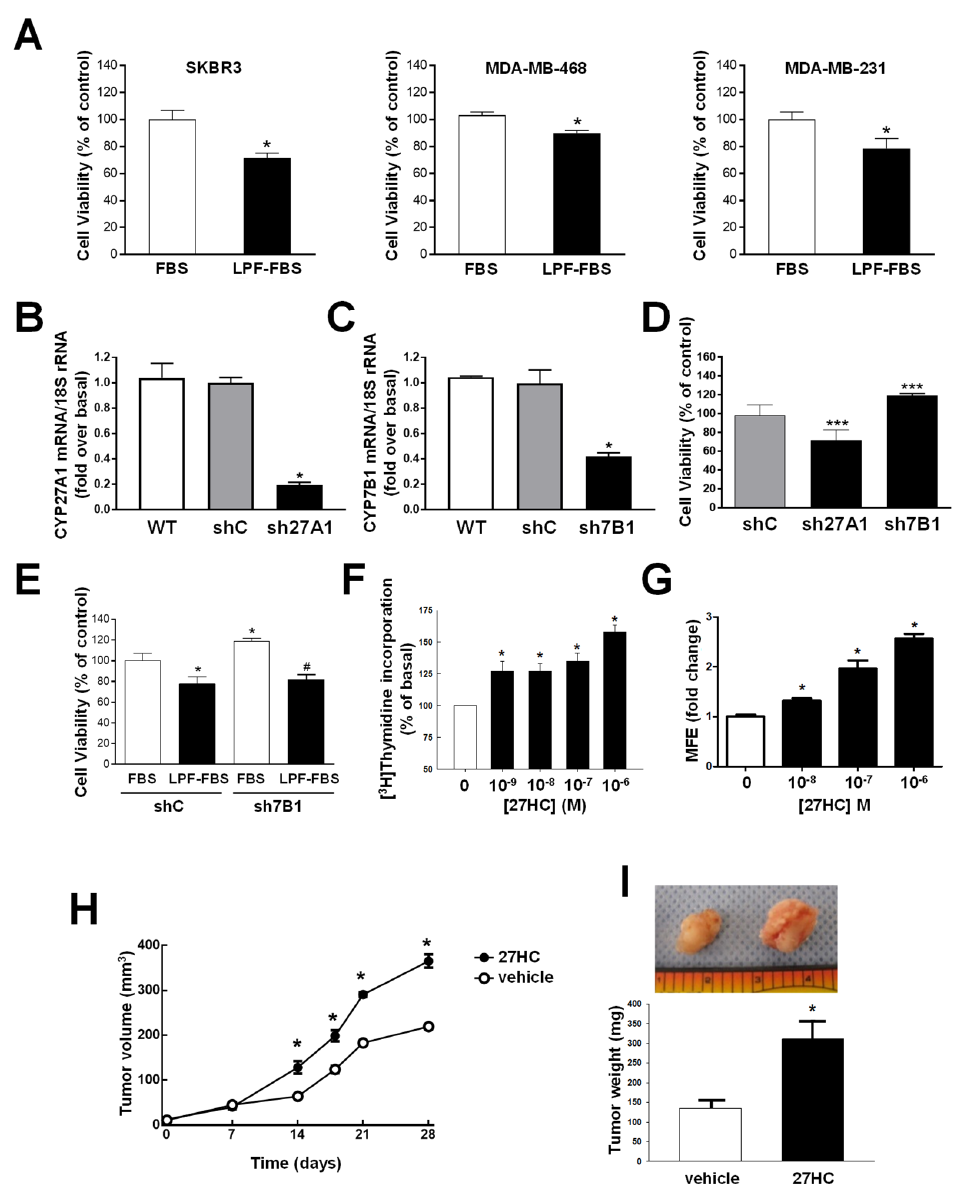
Figure 1. Cholesterol metabolism to 27HC increases ER − BC growth. ( A ) SKBR3, MDA-MB-468 and MDA-MB-231 were grown for 96 h in the presence of 5% FBS or lipoprotein-free FBS (LPF-FBS) (SIGMA), and cell viability was evaluated by MTT assay. * p < 0.05 vs. FBS. ( B , C ). MDA-MB-231 were stably silenced by CYP27A1 (sh27A1) ( B ) and CYP7B1 (sh7B1) ( C ) using gene-specific shRNA. ( D ) Cell viability of sh27A1 and sh7B1 cells was evaluated by MTT assay in comparison to shcontrol (shC) cells at 96 h. *** p < 0.001 vs. shC. ( E ) ShC and sh7B1 cells were grown for 96 h in the presence of 5% FBS or 5% LPF-FBS. * p < 0.05 vs. shC-FBS; # p < 0.05 vs. sh7B1-FBS. ( F ) Proliferation was evaluated by 3 H-thymidine incorporation in MDA-MB-231 cells treated for 48 h with increasing concentrations of 27HC, * p < 0.05 vs. 0 µ M 27HC. ( G ) MDA-MB-231 cells were cultured under non-adherent conditions and grown in the presence of vehicle (0 M) or 27HC (10 − 8 , 10 − 7 , 10 − 6 M) for 5 days, and spheres > 50 µ m were quantified. Findings are expressed relative to mammosphere formation efficiency (MFE) under basal conditions (0 M). Values are mean ± SEM, n = 9, * p < 0.05 vs. vehicle. ( H , I ). Xenografts were initiated using MDA-MB-231 cells, and the mice were administered vehicle versus 27HC for 28 days. ( H ) Growth curves of tumors measured by caliper. * p < 0.05 vs. 0 µ M 27HC. ( I ) Representative tumors and final tumor weights. Values are mean ± SEM, n = 7, * p = 0.009 vs.